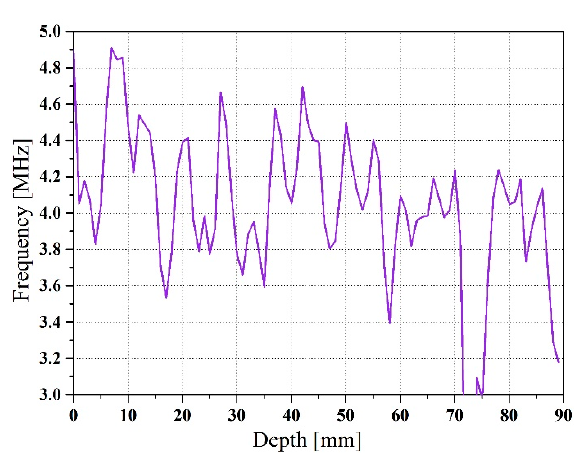
Figure 5. The block power spectrum.